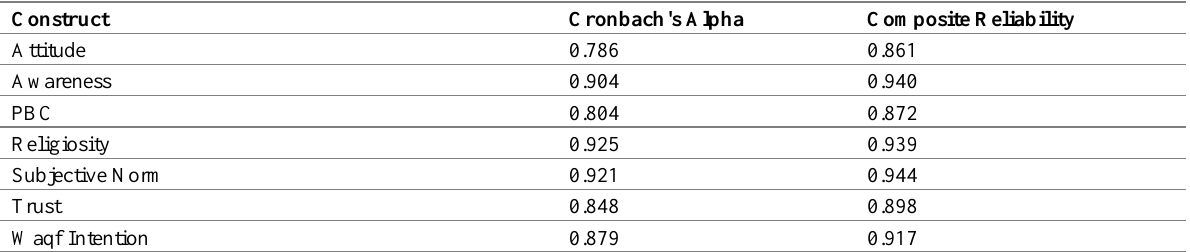
Table 4: Reliability